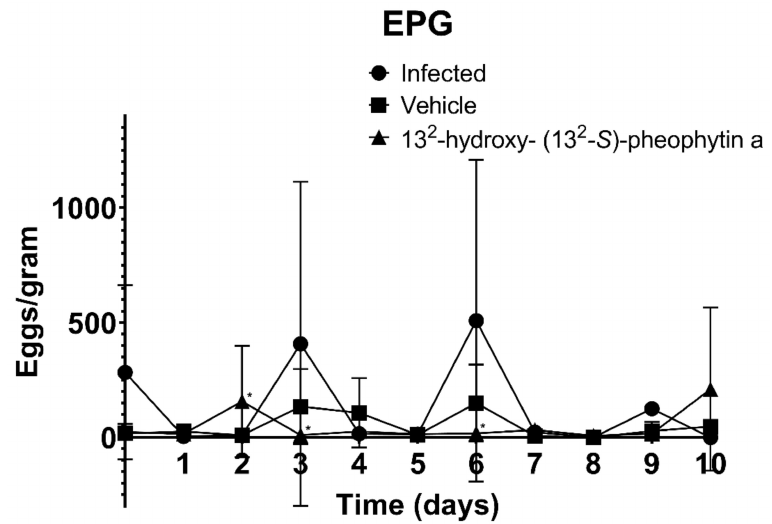
Figure 6. EPG examination of male BALB/c mice infected by H . nana for 10 days over treatment period. After infection, 13 2 -hydroxy-(13 2 -S)-pheophytin a was administered orally at 0.025 g/kg/day for 10 days, and a comparison was made with the infected group. * p < 0.05 indicates a significant difference versus the infected group.